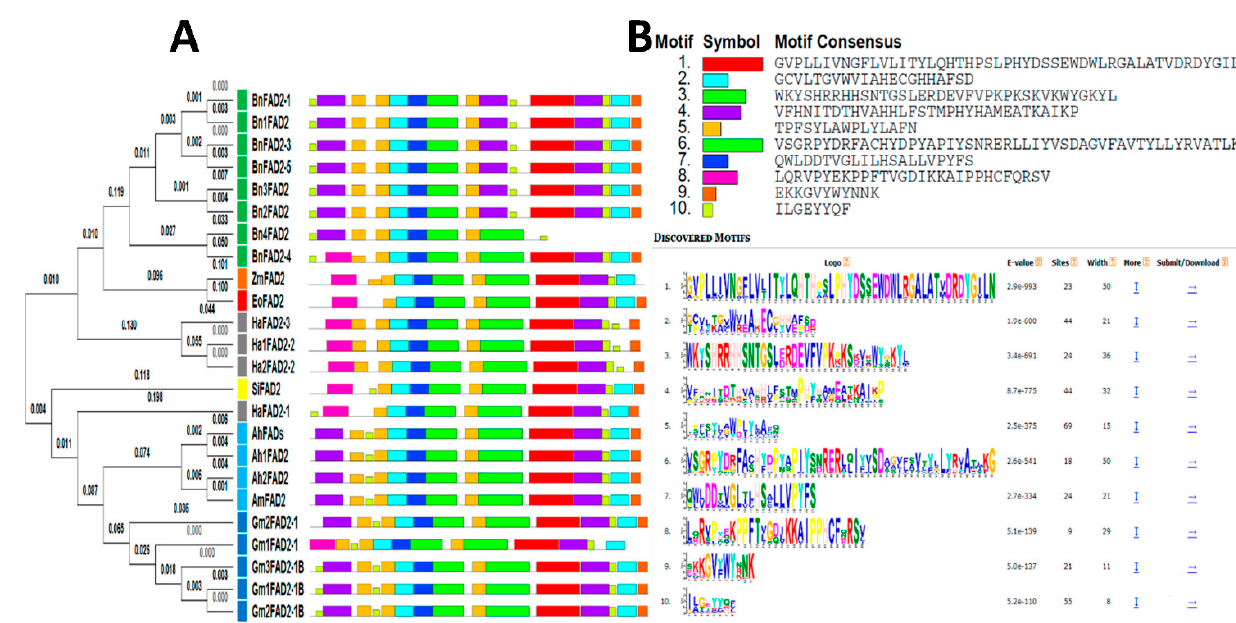
Figure 1. ( A ) Phylogenetic tree of 24 FAD2 protein sequences from eight oilseed species studied using the MEGA program and neighbor-joining analysis with the schematic representation of their conserved motifs identified by the MEME server, described in ( B ).